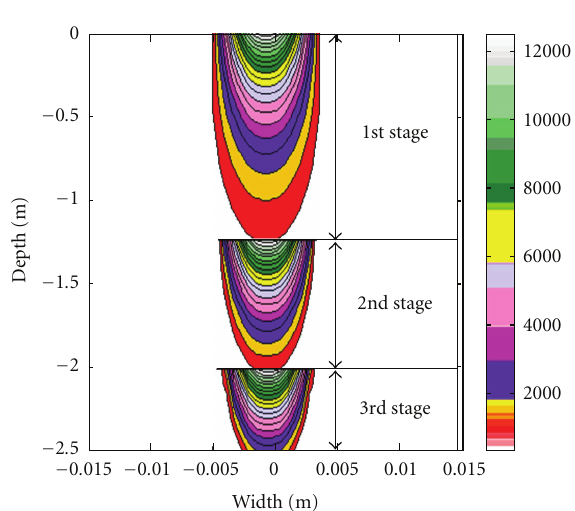
Figure 8: The first-stage temperature distribution; exposure time ( s ) = 2 . 25, total power ( W ) = 2 . 45, and surface temperature = 1 . 5364e + 004. The second-stage temperature distribution; expo- sure time (s) = 2 . 25, total power ( W ) = 0 . 3528, and surface temperature = 2 . 2124e + 003.